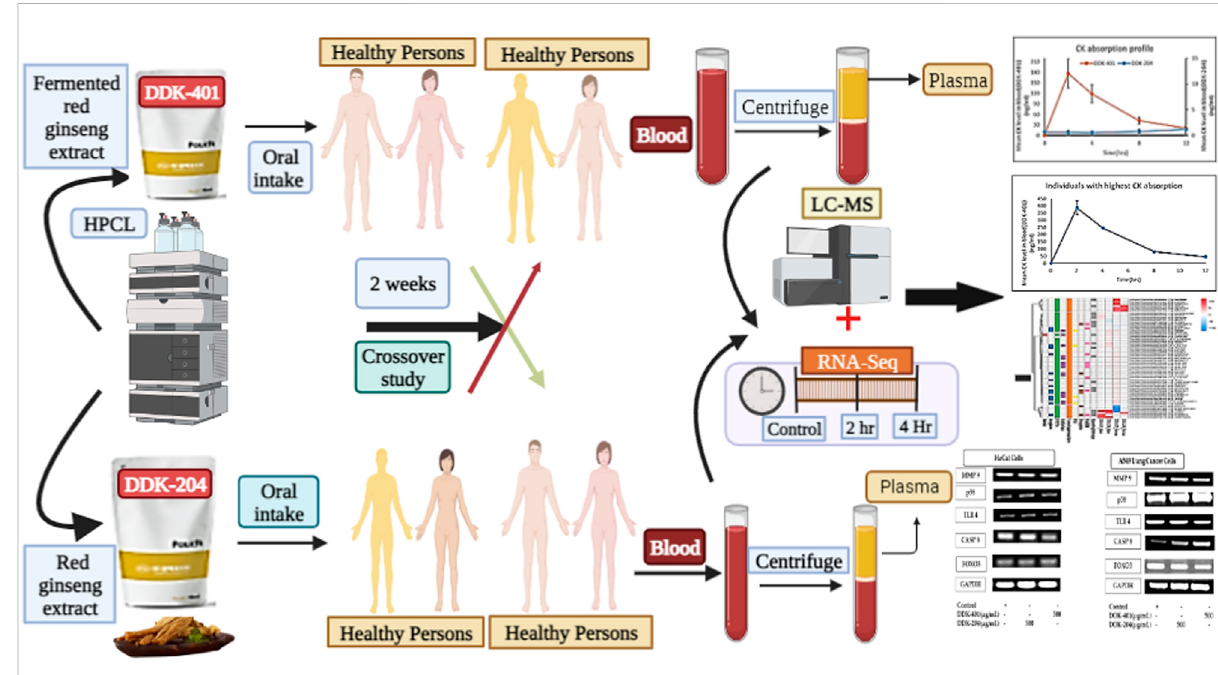
FIGURE 1 Graphical illustration of the fermented red ginseng extract (DDK-401) and red ginseng extract (DDK-204) analyzed by Korean